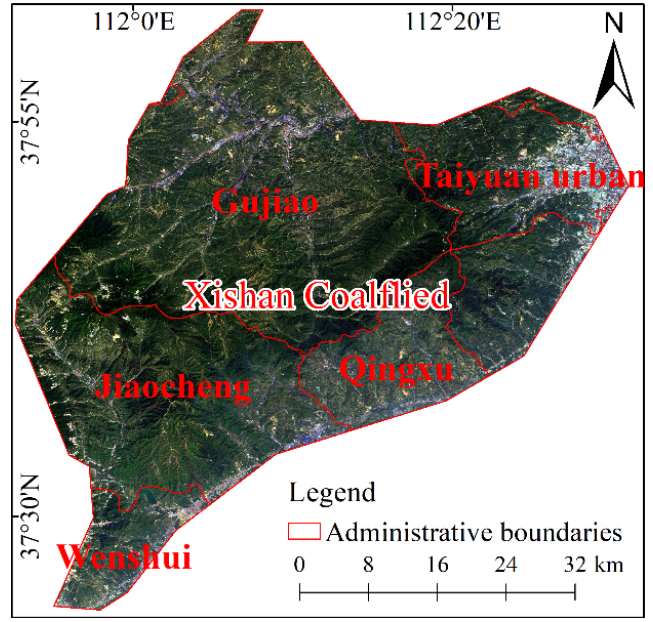
Figure 1. Geographic location of Xishan Coalfield. Landsat 8 panchromatic and multispectral fusion image.